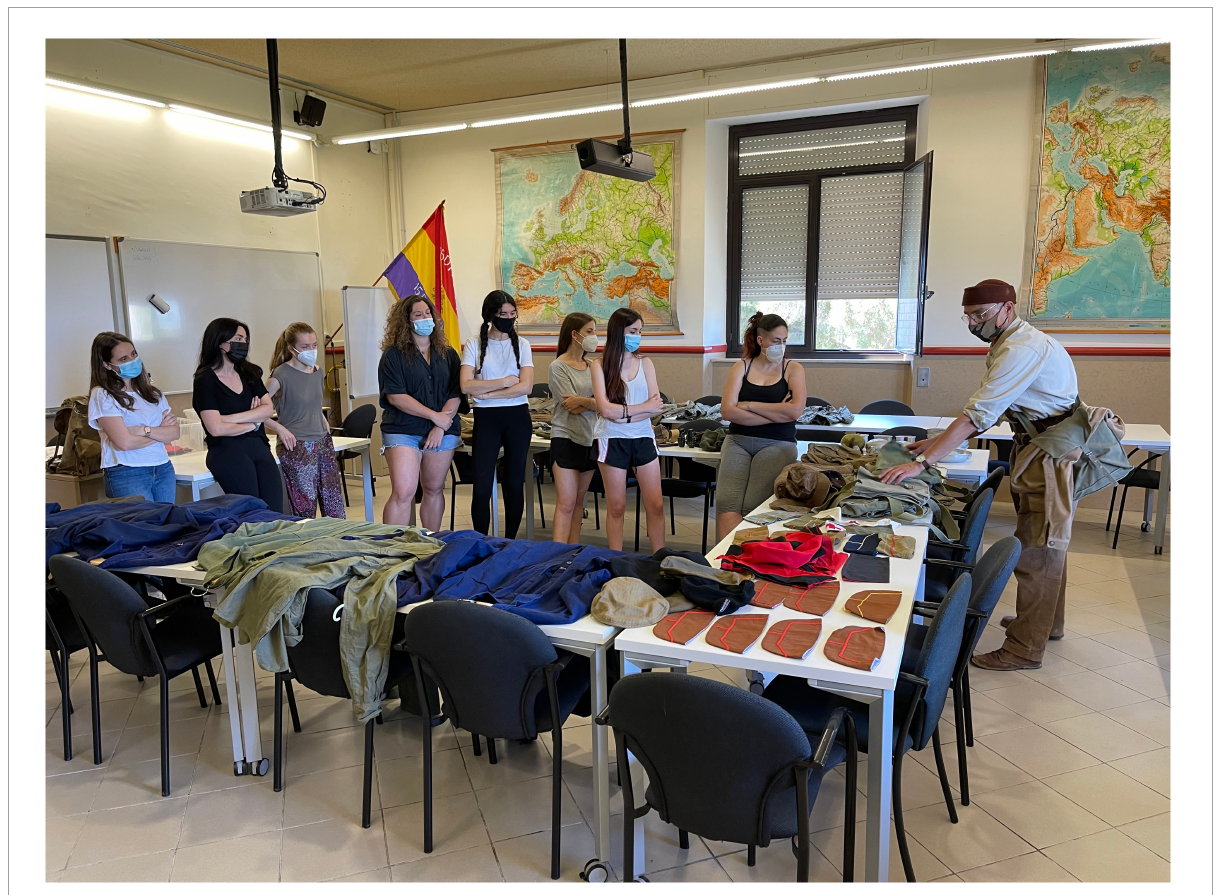
FIGURE1 Teacher training students at the University of Barcelona about to dress up as soldiers of the Spanish Republic during a historical re-enactment